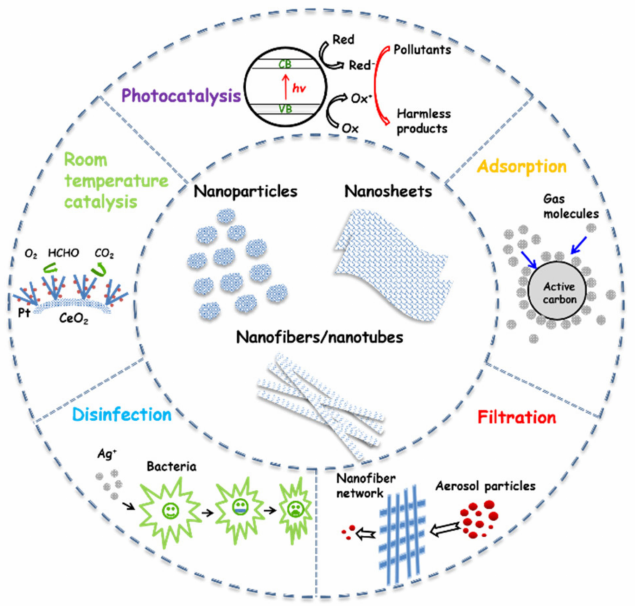
Figure 1. Technologies used for ambient air purification by